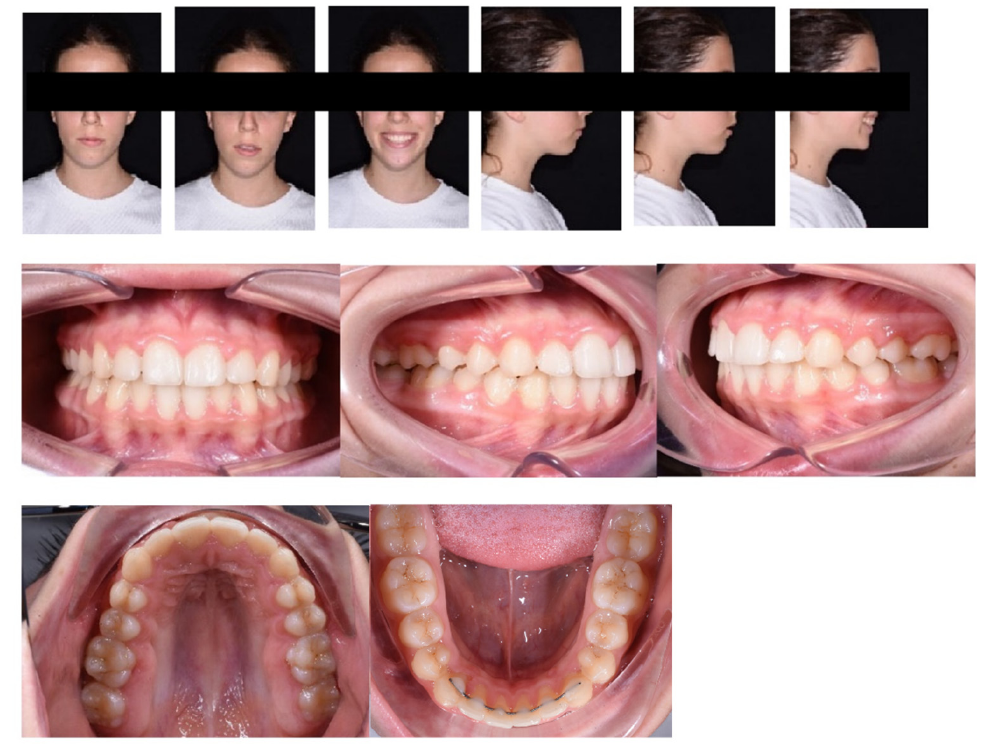
Figure 12. Post-treatment facial and intraoral photographs.